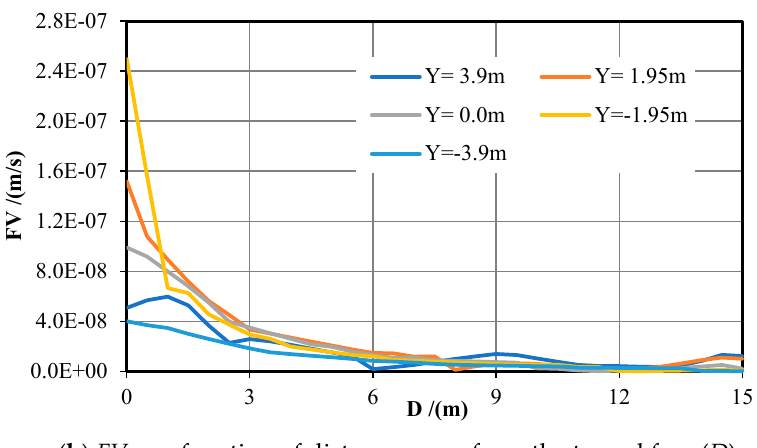
Figure 3. Pore pressure and flow velocity within 30 m ahead of the tunnel face as a function of distance away from the tunnel face (Y = 40 m).